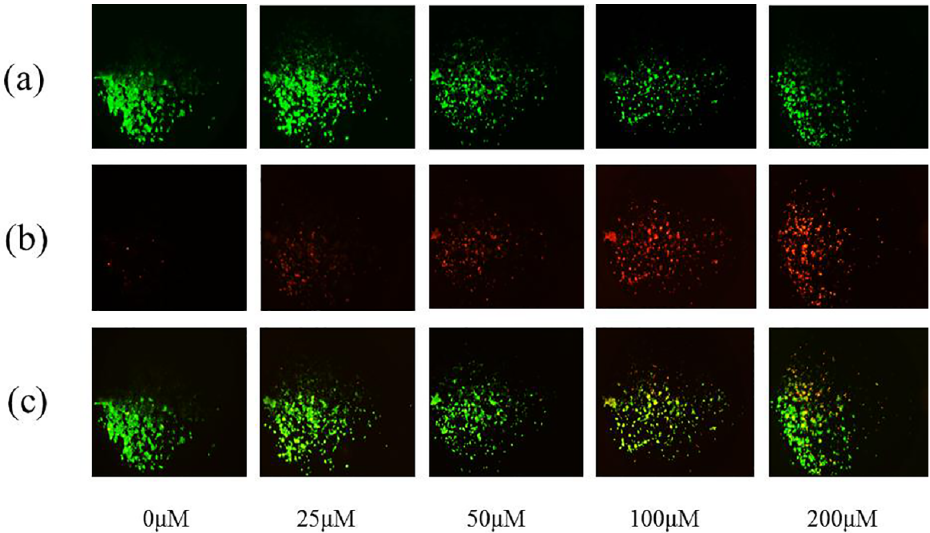
Figure 5. Fluorescence images of HepG2 cells exposed to emodin (0, 25, 50, 100, and 200 µ M) for 48 h by live/dead assay kit. ( a ) Fluorescence images of living cells at different concentrations of emodin (0, 25, 50, 100, and 200 µ M). ( b ) Fluorescence images of dead cells at different concentrations of emodin (0, 25, 50, 100, and 200 μ M). ( c ) Merged fluorescence images of dead and alive cells.